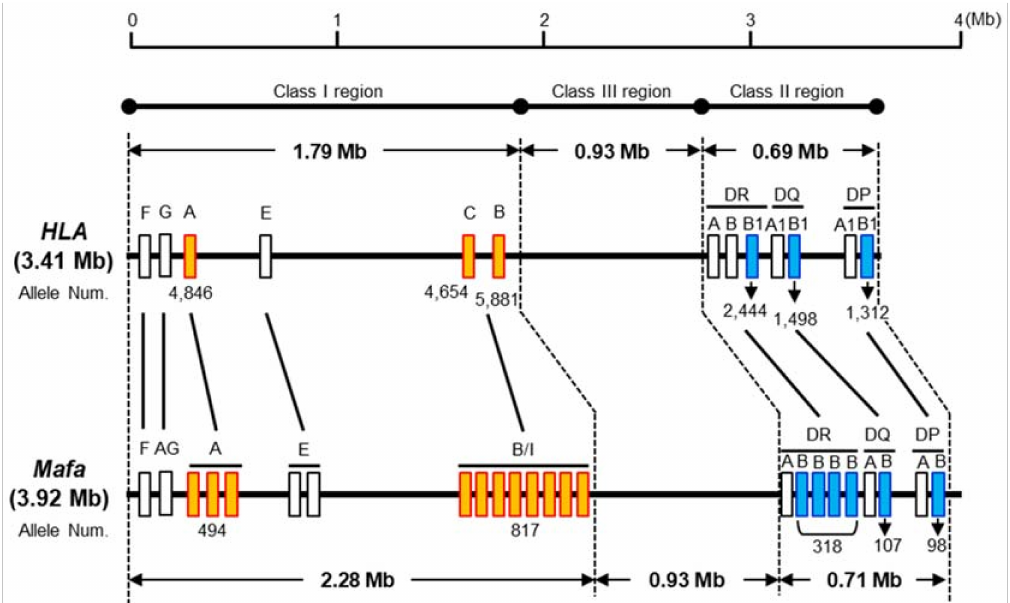
Figure 2. Comparative genome map of the HLA and Mafa regions. The number of Mafa -A, Mafa -B, and Mafa -DRB loci varies from one haplotype to another ( Mafa -A from 1 to 3 loci, Mafa -B / I from 2 to 9, Mafa -DRB from 2 to 4). The numbers below the boxes indicate the number of alleles based on the IPD-IMGT / HLA version 3.35 and IPD-MHC version 3.2.0.0 database. The numbers of Mafa -A, Mafa -B and Mafa -DRB alleles correspond to the allele numbers of all Mafa -A loci ( Mafa -A1 to -A6 and Mafa -A8), all Mafa -B loci ( Mafa -B, -B11L -B12, -B16, -B17, -B20 and -B21), as well as all Mafa -DRB loci ( Mafa -DRB*W, -DRB1, -DRB3, -DRB4, -DRB5 and -DRB6). For more details on allele numbers, see Table